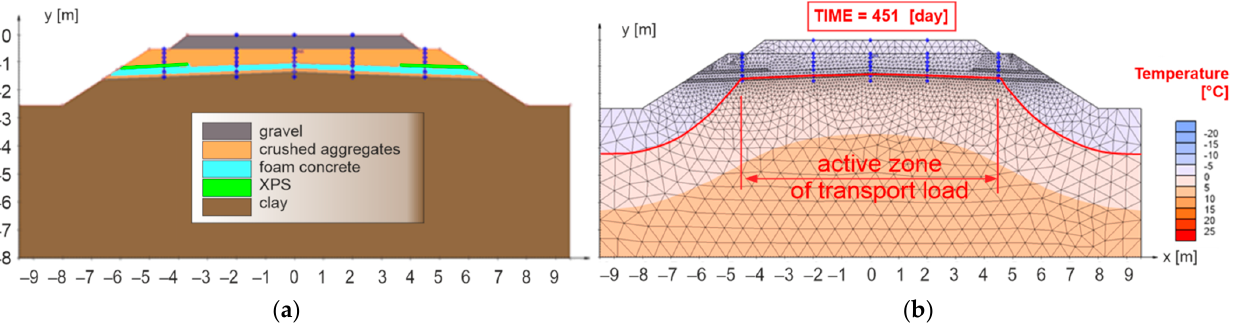
Figure 13. Numerical model No. 3—double-track railway with horizontal sub-ballast upper surface and with built-in composite layer of FC and XPS for applied climate conditions I F = 1400 °C, day and θ m = 2 °C ( a ), day of reaching the highest freezing depth of structural layers of the numerical model ( b ).